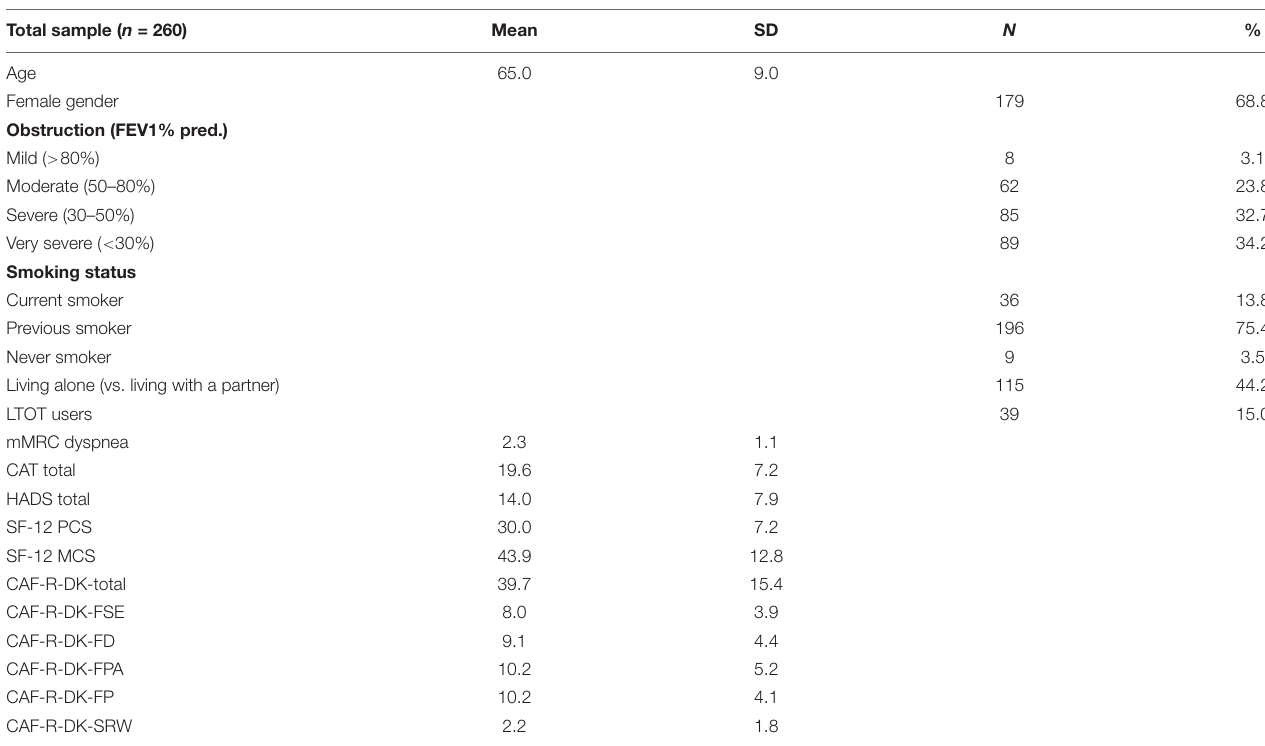
TABLE 1 | Participant